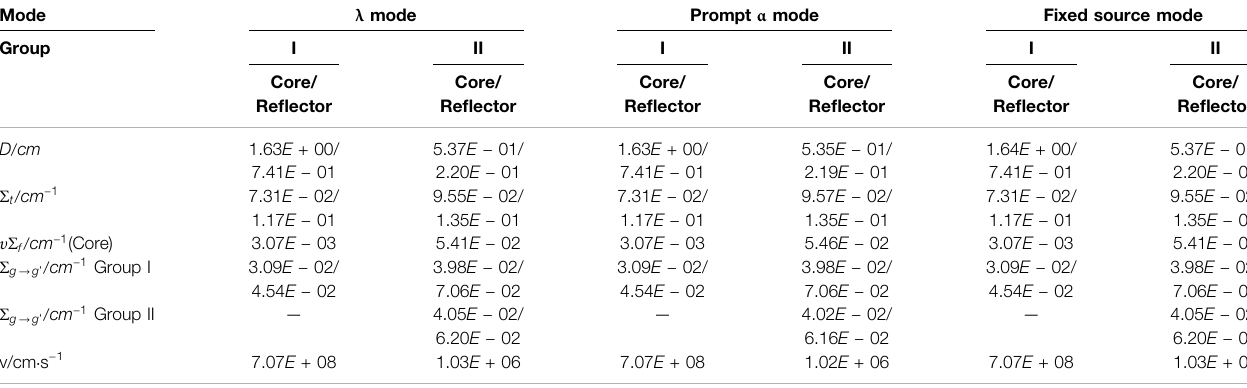
TABLE 2 | Homogeneous and condensate parameters of core/re fl ector in ADSR (k eff (cid:2) 0.99).